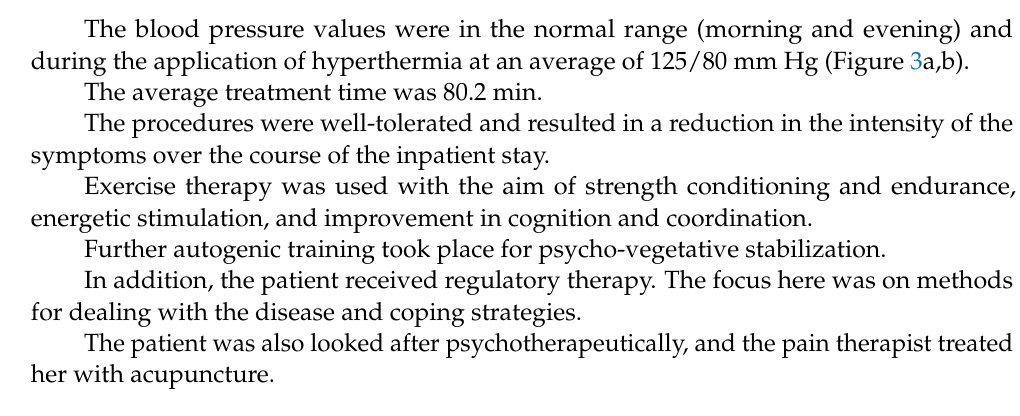
Figure 2. The results of pulse monitoring.